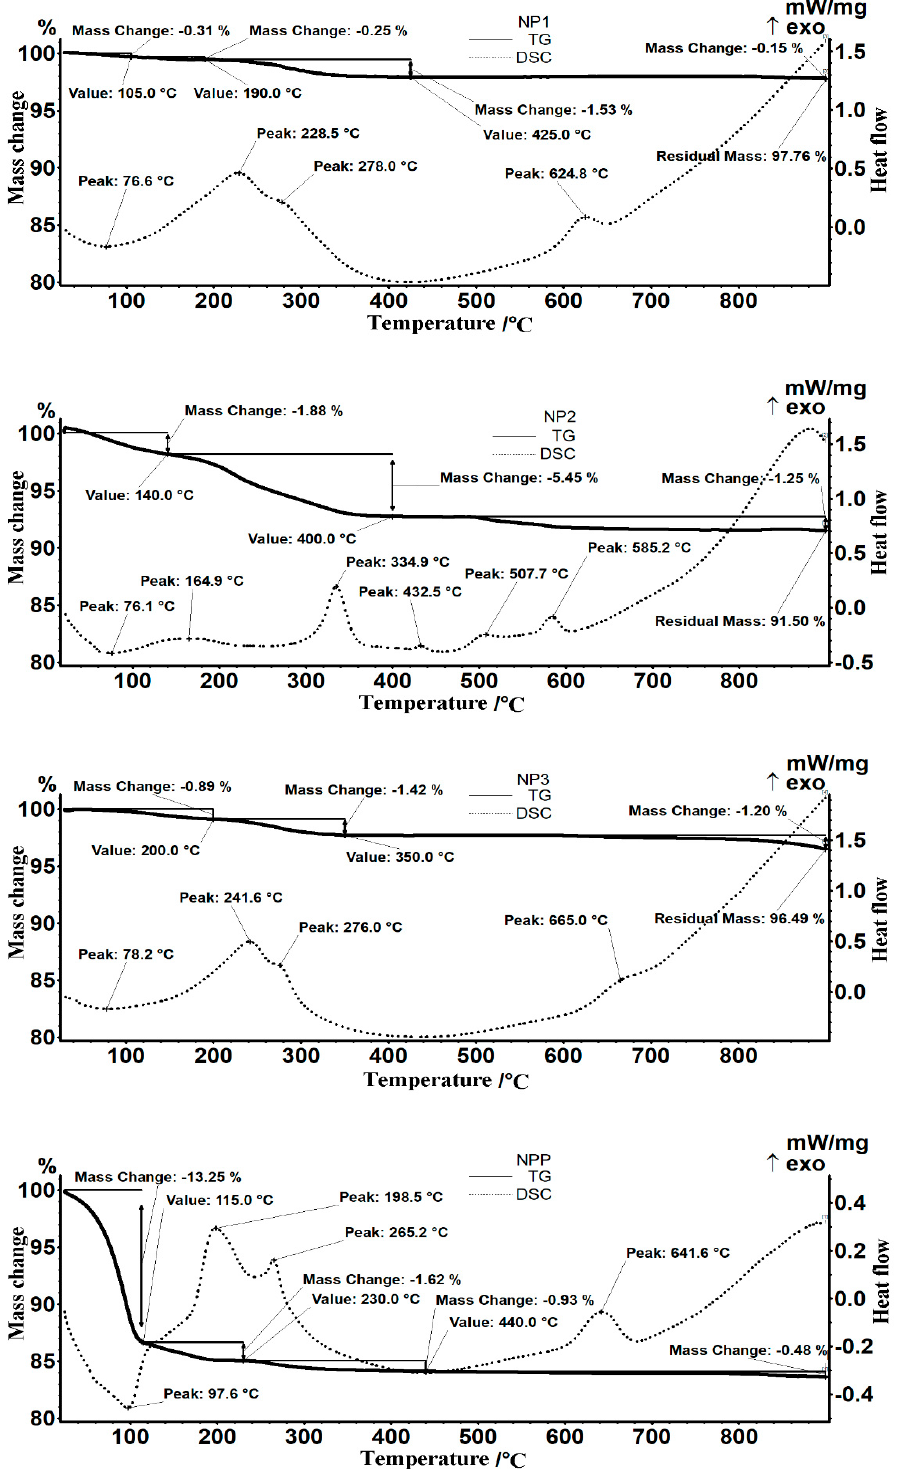
Figure 4. Detailed thermal diagrams for nanoparticles: NP 1 , NP 2 , NP 3, and a sample of nanoparticles after processing (NPP). The magnetization diagrams for the prepared nanoparticles are shown in Figure 5.